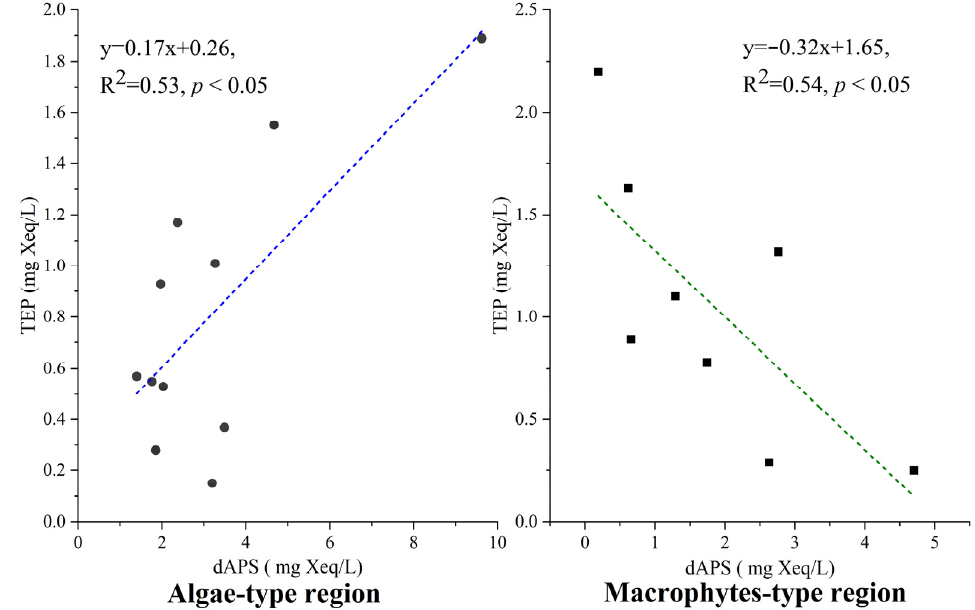
Figure 3. The relationship between transparent exopolymer particles (TEP) and dissolved acidic polysaccharides (dAPS) in algae-type regions and macrophytes-type regions in polysaccharides (dAPS) in algae-type regions and macrophytes-type regions in spring.